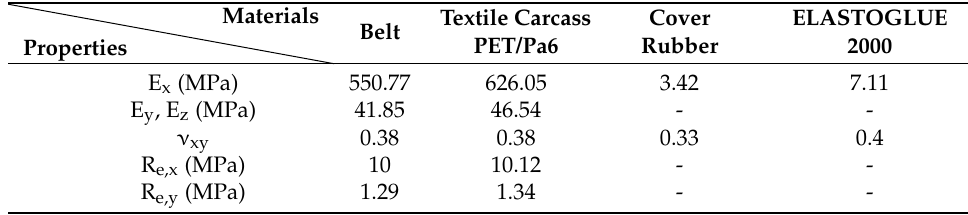
Table 1. Mechanical properties of materials.